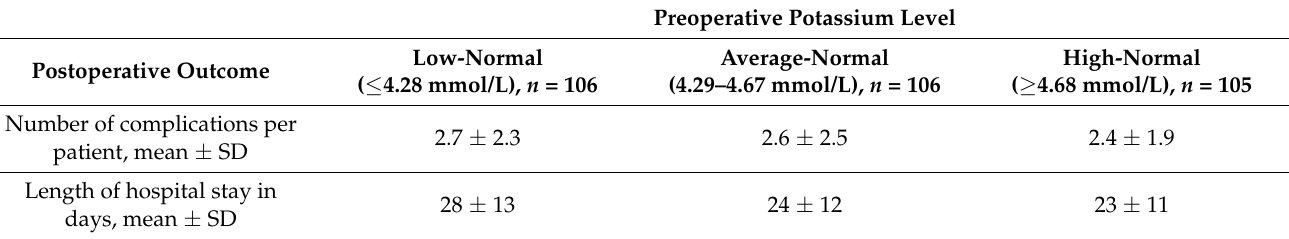
Table 4. Effect of preoperative potassium level on the number of postoperative complications per patient and length of hospital